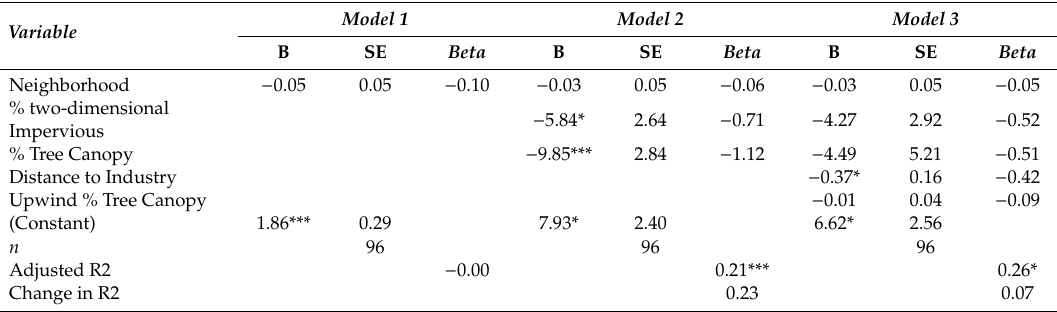
Table 9. Regression analysis for UHI temperatures at 4 p.m. using two-dimensional approach in eight Chicago neighborhoods in summer 2010.